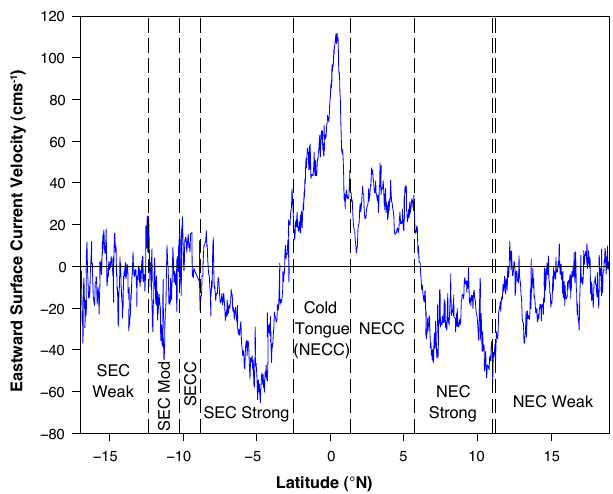
Fig. 4. Eastward 19m current velocity along the cruise transect be- tween ∼ 17.5 ◦ S and 19 ◦ N as measured by acoustic Doppler cur- rent profiler. Dashed lines and associated text labels indicate current regimes identified in Table 1. “Mod” means